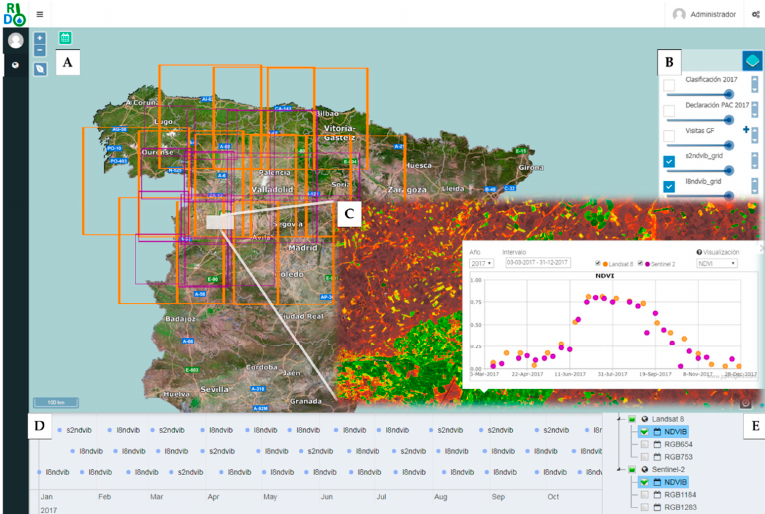
Figure 6. Screenshot of the web-GIS module. ( A ) web-GIS viewer; ( B ) Several layers to visualize, i.e. S2 and L8 grids, 2017 crop classification (source: Agrarian Technological Institute of Castilla y León, ITACYL), crop declarations to the Common Agricultural Policy (CAP) and field inspections; ( C ) Usual NDVI variation graphic for an irrigated summer crop: user could choose to visualize NDVI values from L8, S2 or both satellite platforms; ( D ) Timeline and images availability depending on the area shown by the viewer; ( E ) Selection of derived products to visualize: RGB (Red, Green and Blue) false colour and NDVI images from both L8 and